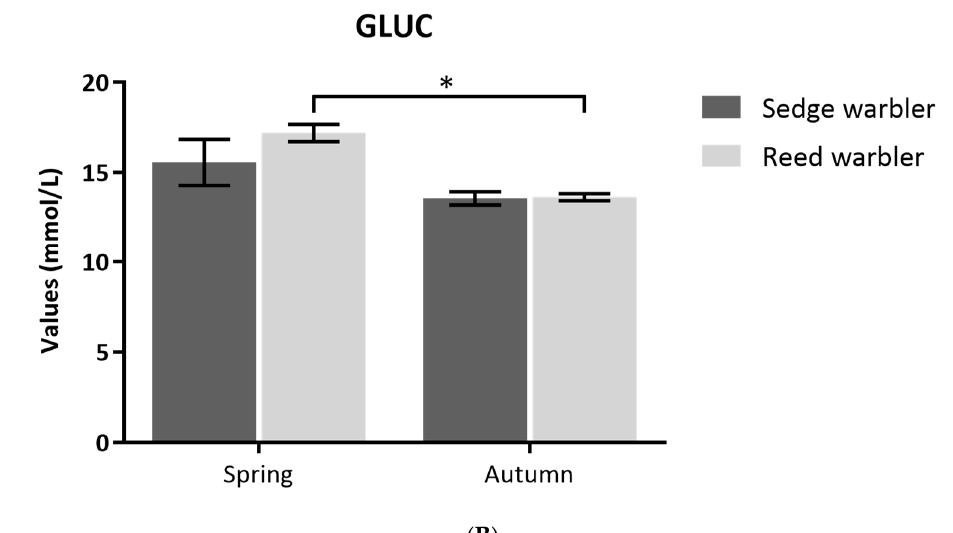
Figure 3. ( A ) Comparison of Triglycerides (TRIG) + Glycerol (GLY) and ( B ) Glucose (GLUC) (mmol/L) values (mean ± SE) measured at field of non-fasting Sedge and Eurasian Reed Warblers (Reed Warbler) captured after stopping naturally during spring and autumn migration. Significance codes: *** = P < 0.001; ** P < 0.01; * P < 0.05.